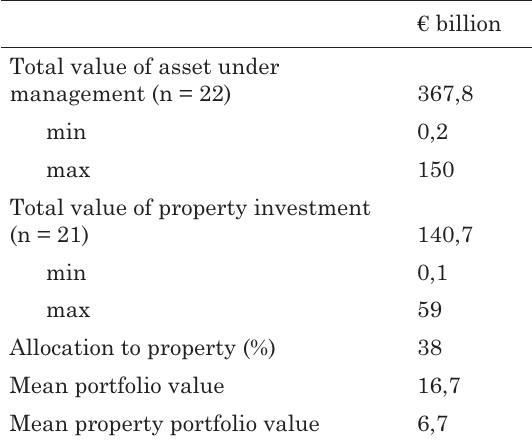
Table 2. Assets under management